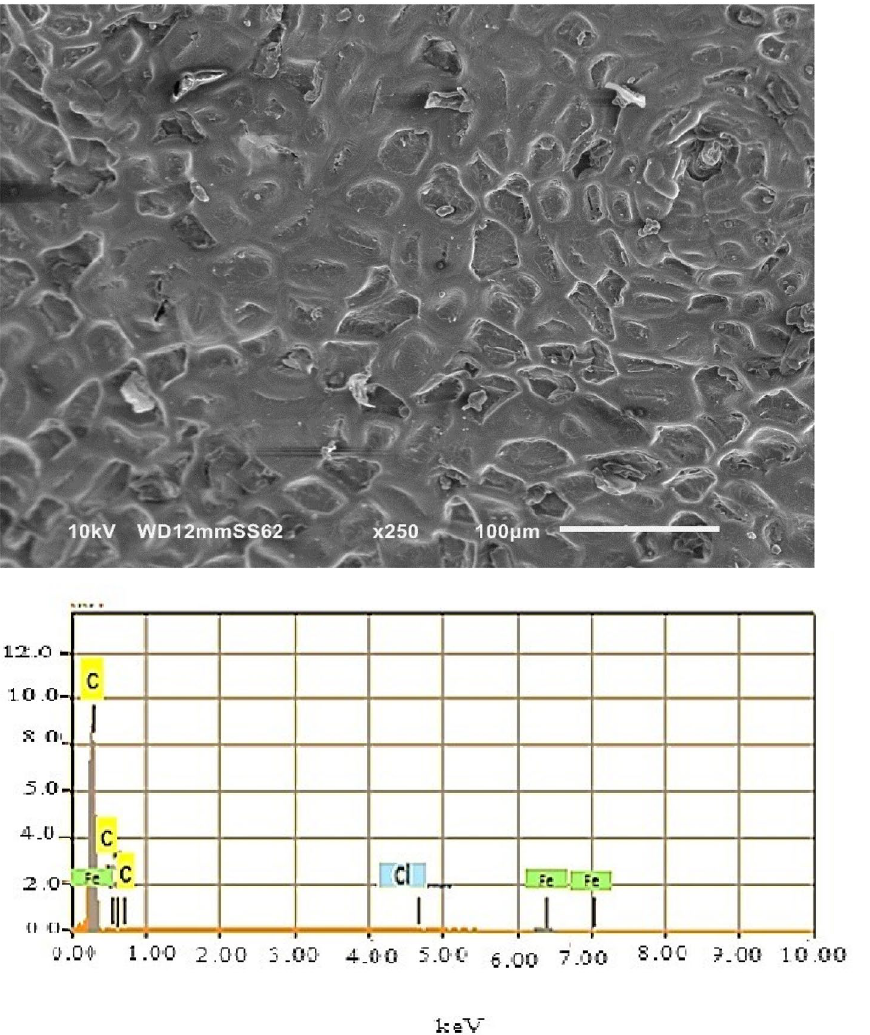
Figure 10. SEM analysis along with EDX of coated melted